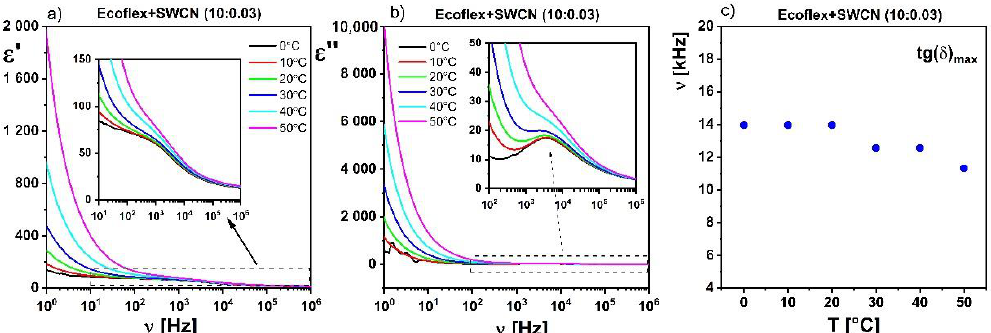
Figure 9. Temperature behavior of the relaxation process observed in Ecoflex ® :SWCN (10:0.03) hybrid layer: ε ’ ( a ), dielectric absorption ( b ), temperature dependence of relaxation frequency tg( δ )max ( c